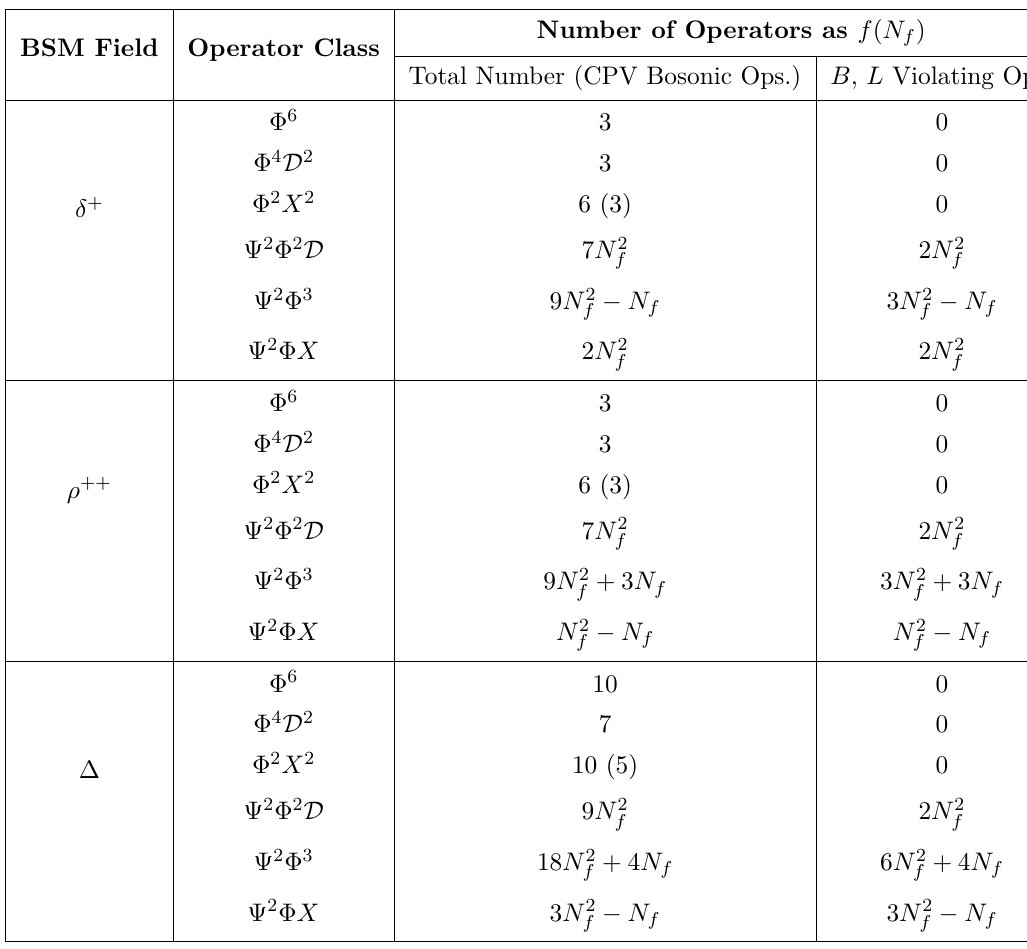
Table 26 . Number of additional operators of different classes at dimension 6 with N f fermion flavours for each BSM model. The numbers in parentheses denote the counting for CP violating purely bosonic